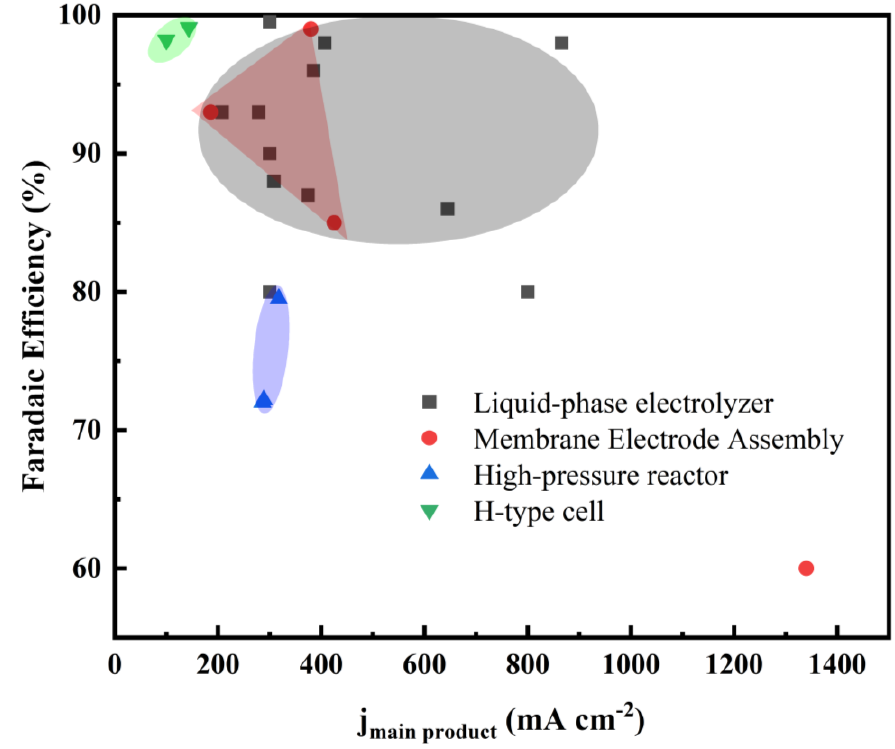
Figure 12. Faradaic efficiency and corresponding current density for CO 2 ER in different reactors.